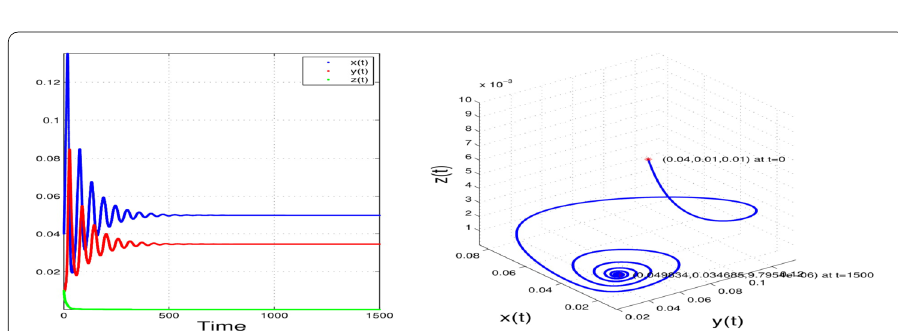
Figure 2 The local stability of the equilibrium (cid:7) 1 = (2.01,0,0.8)